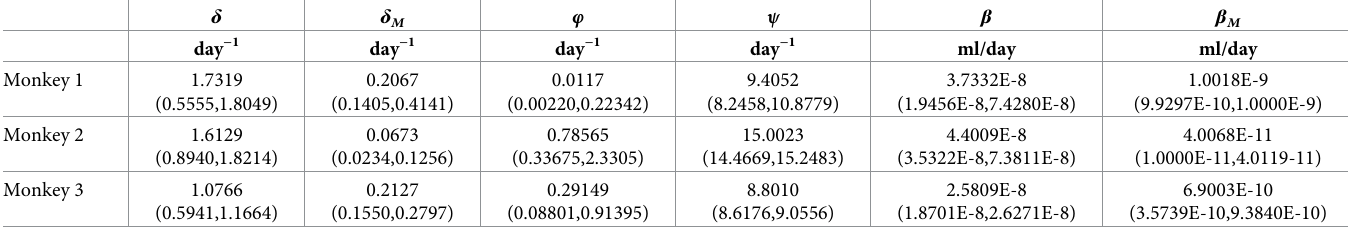
Table 2. Parameter estimates through data fitting. Estimated parameters from fitting the selected model, i.e. Model 1, to each of the three monkey’s data. Paired values in parentheses represent 95% confidence